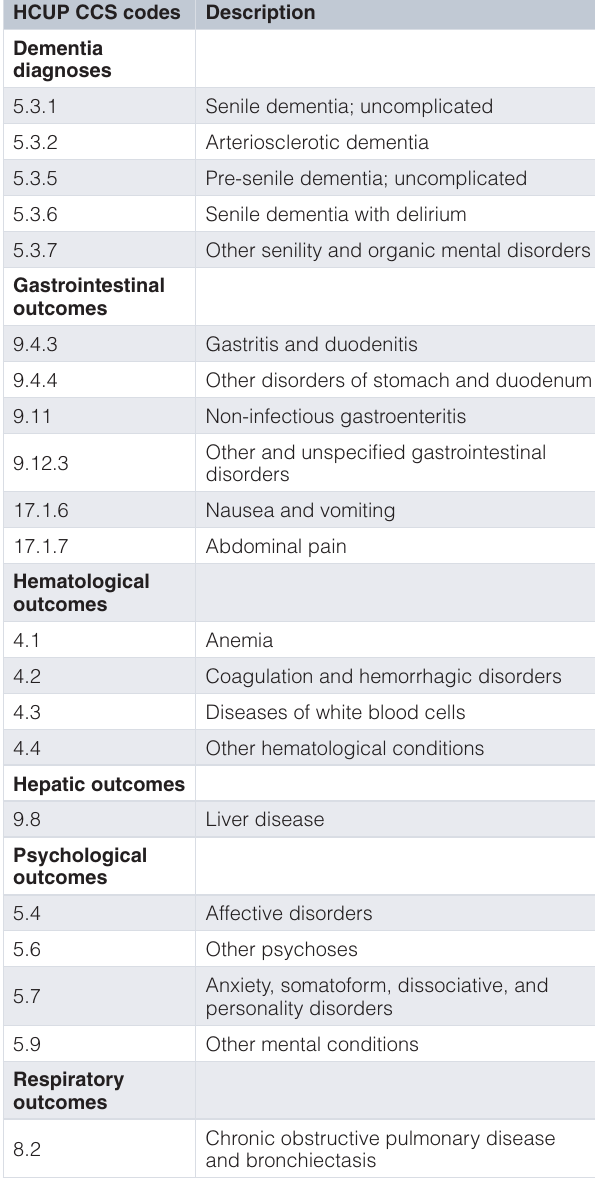
Table 1. Dementia codes and targeted outcomes codes from the Healthcare Cost and Utilization